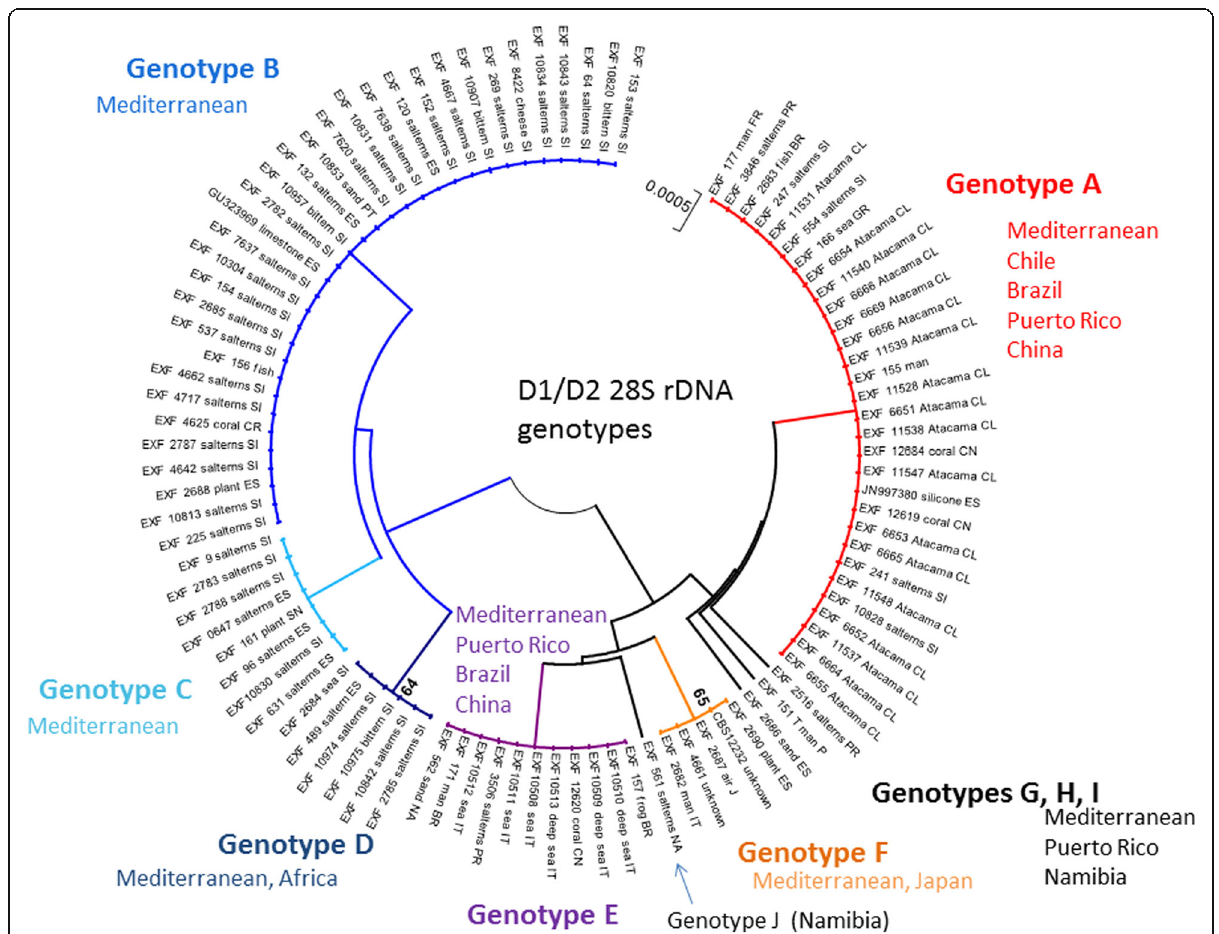
Table 2 Variable sites in Hortaea werneckii alignment of partial D1/D2 28S rDNA sequences